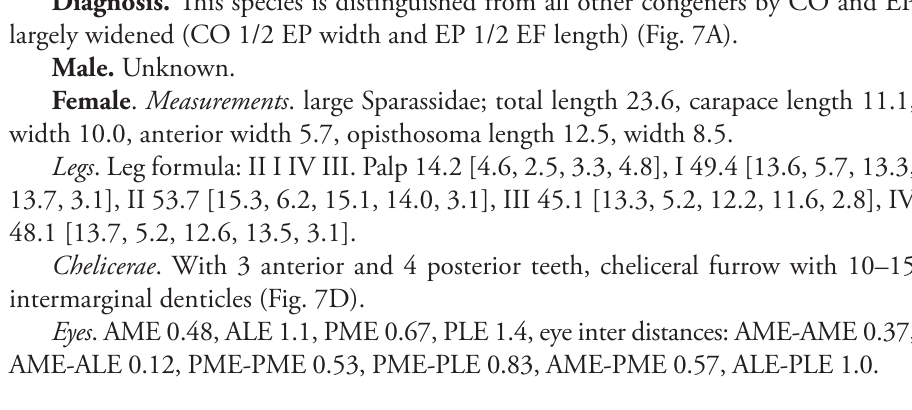
Type material. Holotype : female, IRAN: Hormozgan Province: Hamag Protected area, Southern Zagros, Kuhe Fareghan, Hamag-e-Paeen, 27°51'52.00"N, 56°28'31.00"E, June 2015, S. Sami leg.